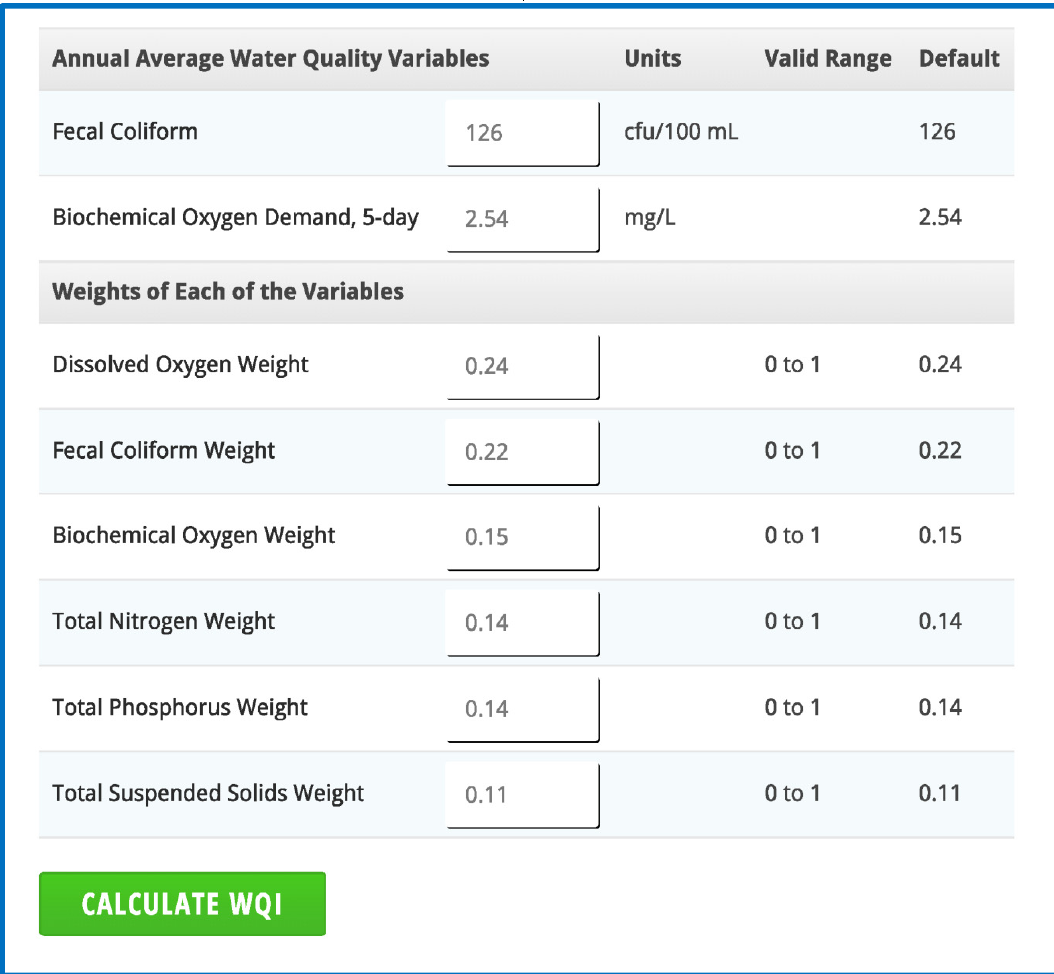
Figure 7. Hydrological outputs (process-based diagram) generated by SWAT-Check (diagrams for sediment and nutrient processes are also available in SWAT-Check [2].